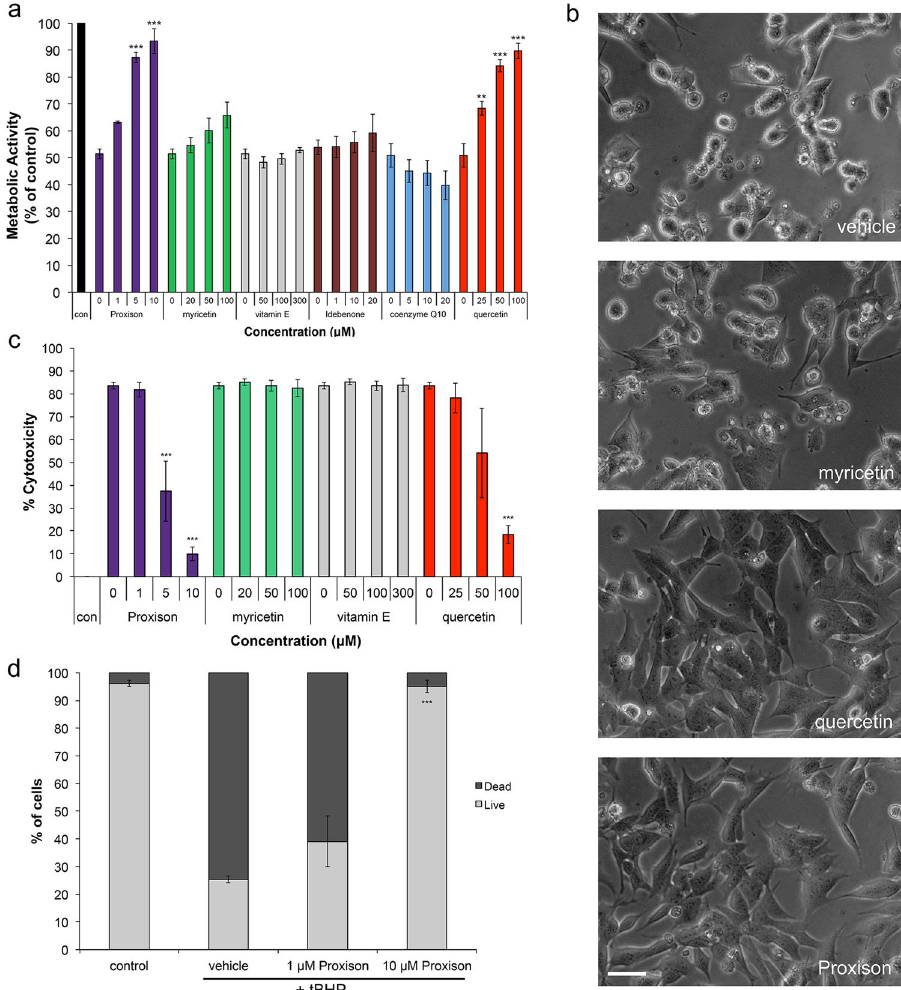
Figure 2. Antioxidant protection against acute oxidative stress. ( a ) Metabolic activity of SH-SY5Y cells treated with 400 μ M t BHP for 4 hours in the absence or presence of differing concentrations of 6 antioxidants (n = 3). ( b ) Phase-contrast microscopy of t BHP-treated SH-SH5Y cells treated with DMSO (vehicle), myricetin, quercetin, or Proxison. Scale bar: 75 μ m. ( c ) t BHP-induced cytotoxicity was determined at 16 hours with the LDH assay in the absence or presence of 4 antioxidants (n = 3). ( d ) The percentage of dead cells was assessed at 16 hours by PI FACS analysis for Proxison-treated cells (n = 2). ANOVA with a Tukey’s post-hoc test was performed to assess the significant difference between antioxidant-treated and vehicle-treated cells in ( a ), ( c ), and ( d ); ** p < 0.01, *** p <